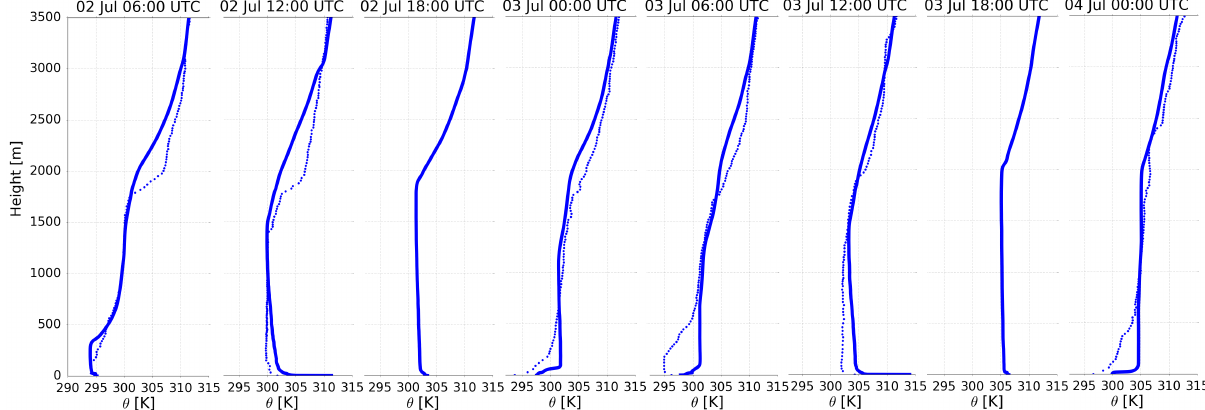
Figure 7. The vertical profiles of potential temperature modelled by PALM (solid line) and supplemented by radiosonde observations from station Prague, Libuš (except for hour 18; dotted line). Displayed are profiles from 2 July, 06:00UTC to 4 July, 00:00UTC with a 6h time